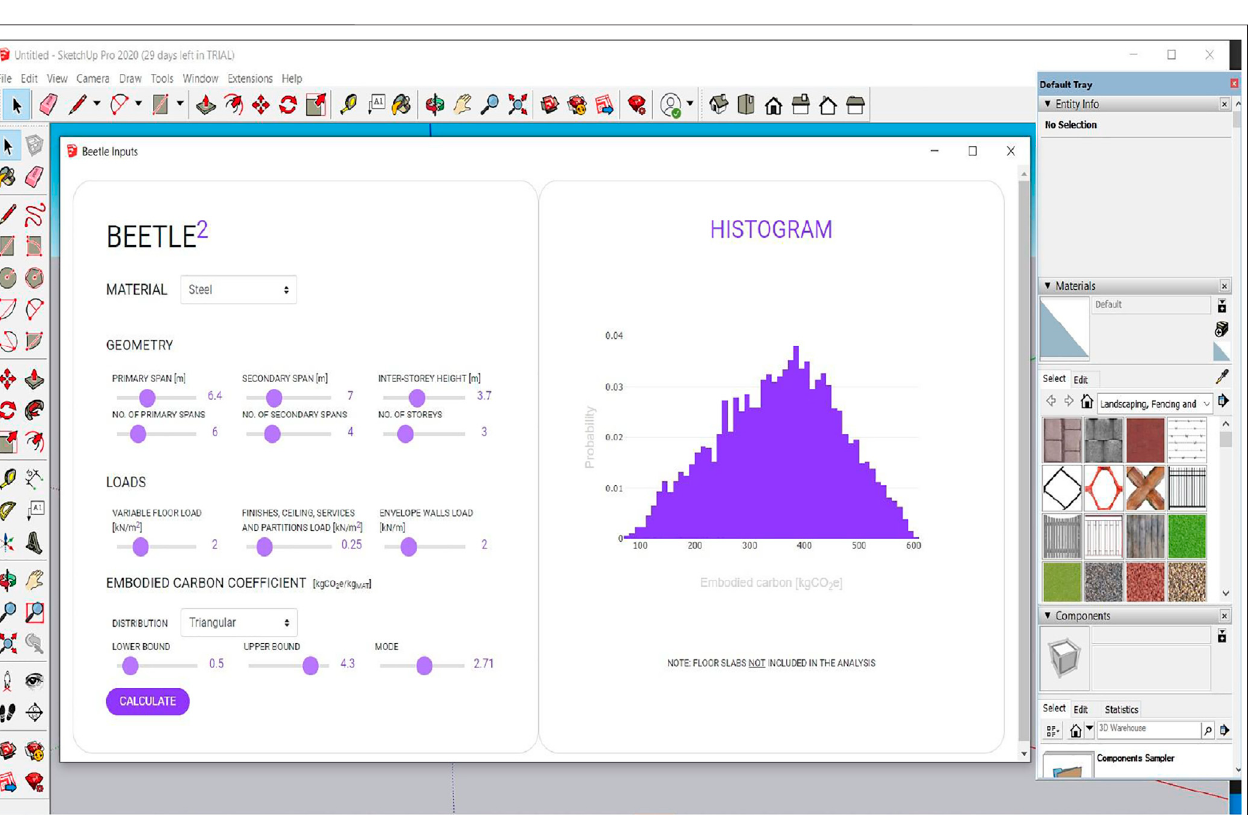
FIGURE 6 | Graphical User interface of the newly implemented tool as a plugin for SketchUp.